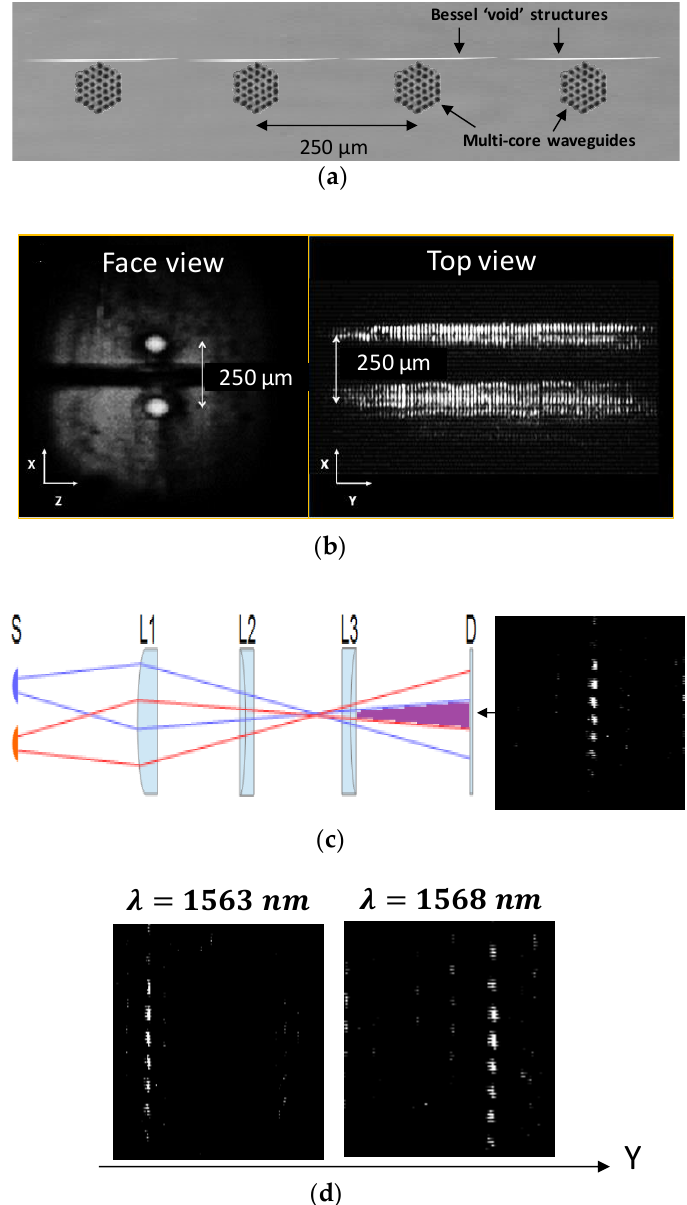
Figure 11. ( a ) Front-view schematic concept of the spectro-interferometer prototype photo-inscribed in bulk GLS, made by four LMA honeycomb multicore cross-section waveguides and transversally photowritten Bessel nanovoids; ( b ) Direct transmission on the FLIR camera, showing the two modes of two adjacent channel waveguides (left) and a top view of the signal extracted with the sampling centers and imaged on the Goodrich Camera using a simple microscope objective (right); ( c ) Left: optical set-up showing overlapping of the signal extracted from two adjacent waveguides as the triplet is defocused from the source plane. Right: corresponding Young fringes obtained on the detector, using a monochromatic source at 1560 nm, when two adjacent channel waveguides are simultaneously injected; ( d ) Image of the vertical interference fringes as they move on the detector (in the Y direction, with respect to Figure 11b) as the wavelength is tuned from 1563 to 1568 nm.